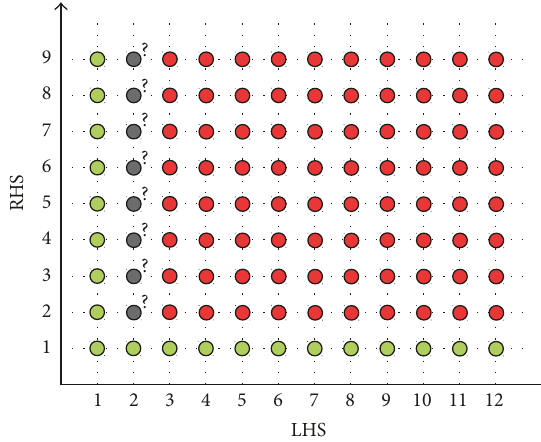
Figure 1: Summary of the results and open problems.